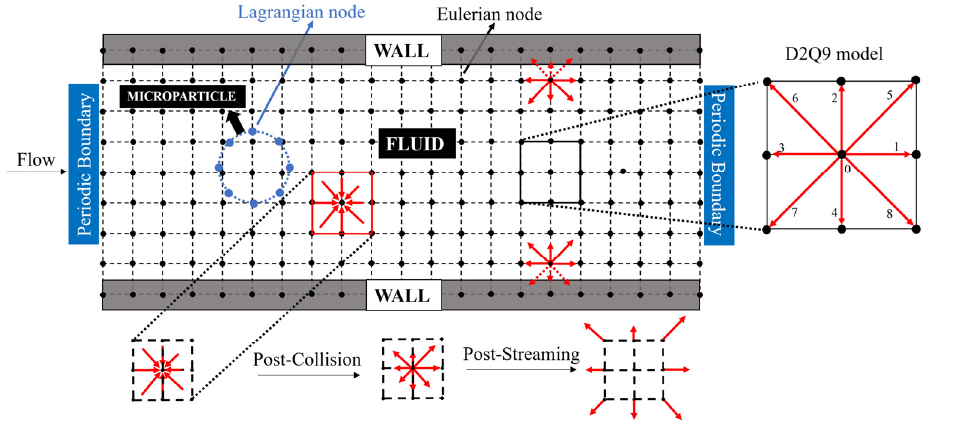
Figure 1. Schematics of the IB-LBM computational domain based on the D2Q9 model and the boundary